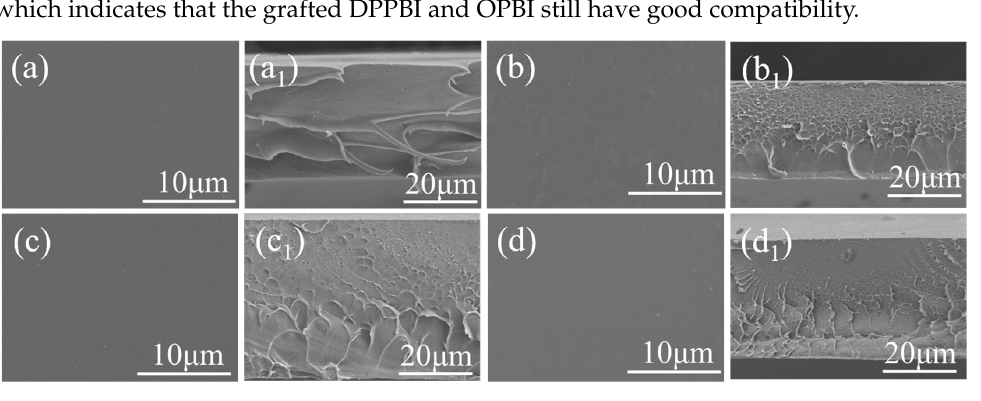
Figure 3. FT–IR spectra of the DPPBI and grafted ImDPPBI.